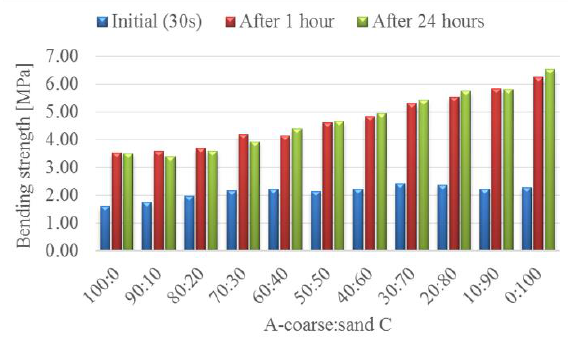
Figure 14. Strength behavior for sand combination A coarse and sand C.